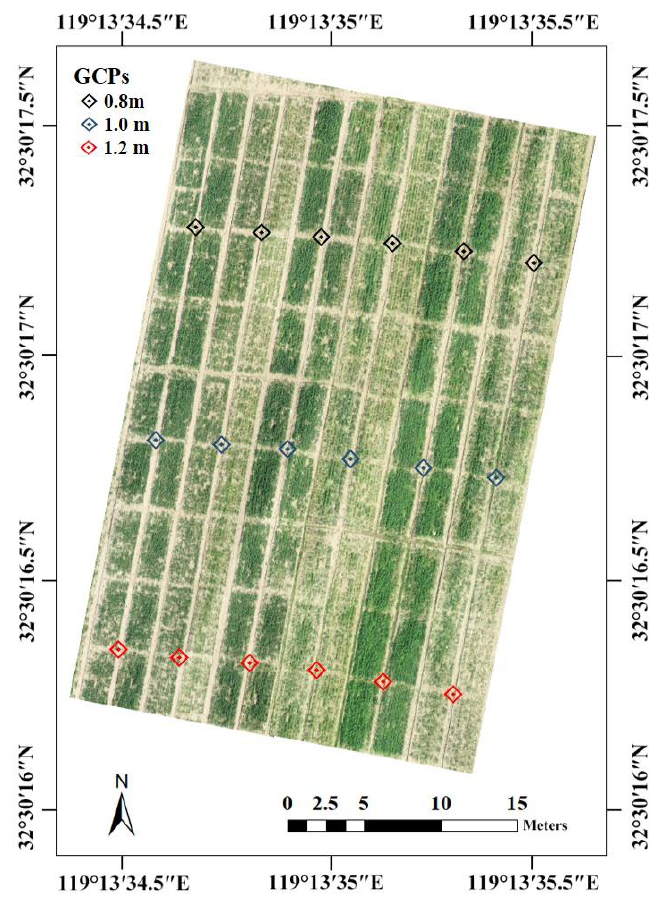
Figure 1. Wheat experiments conducted at the Yizheng Experimental Station in Jiangsu Province, China. Table 1. Information on the field experiments.